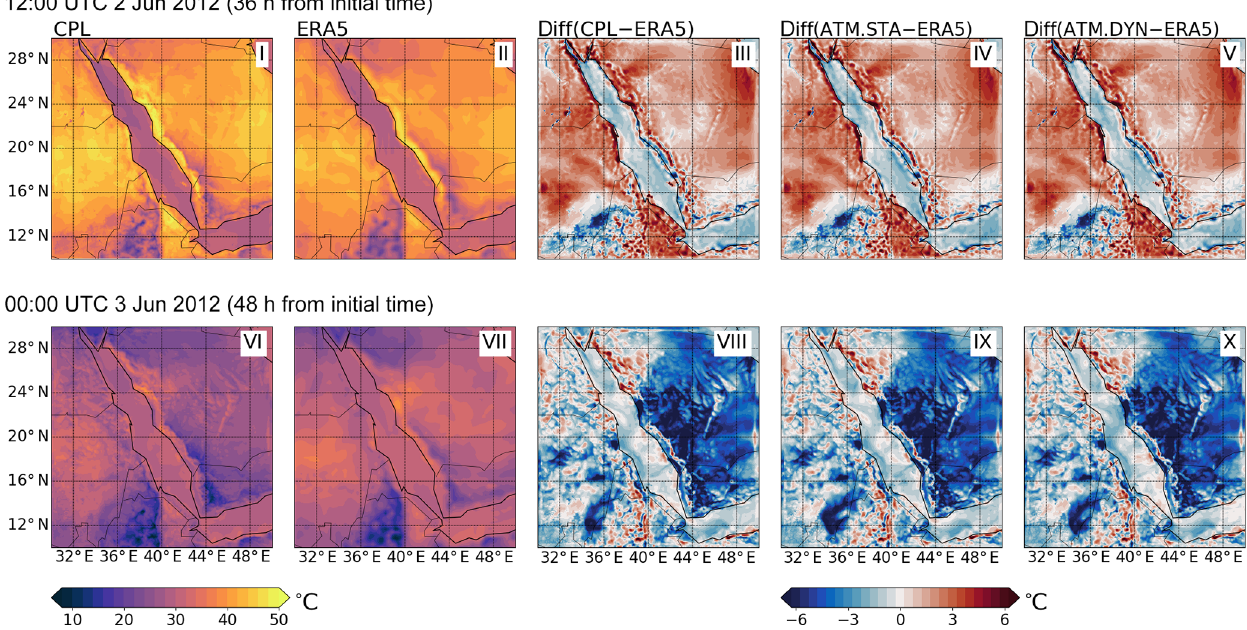
Figure 4. The 2m air temperature as obtained from the CPL, the ERA5 data, and their difference (CPL − ERA5). The differences be- tween ATM.STA and ATM.DYN with ERA5 (i.e., ATM.STA − ERA5, ATM.DYN − ERA5) are also presented. The simulation initial time is 00:00UTC 1 June 2012 for both snapshots. Two snapshots are selected: (1) 12:00UTC 2 June 2012 (36h from initial time) and (2) 00:00UTC 3 June 2012 (48h from initial time). The results on 2 June are presented because the record-high temperature is observed in the Mecca region.